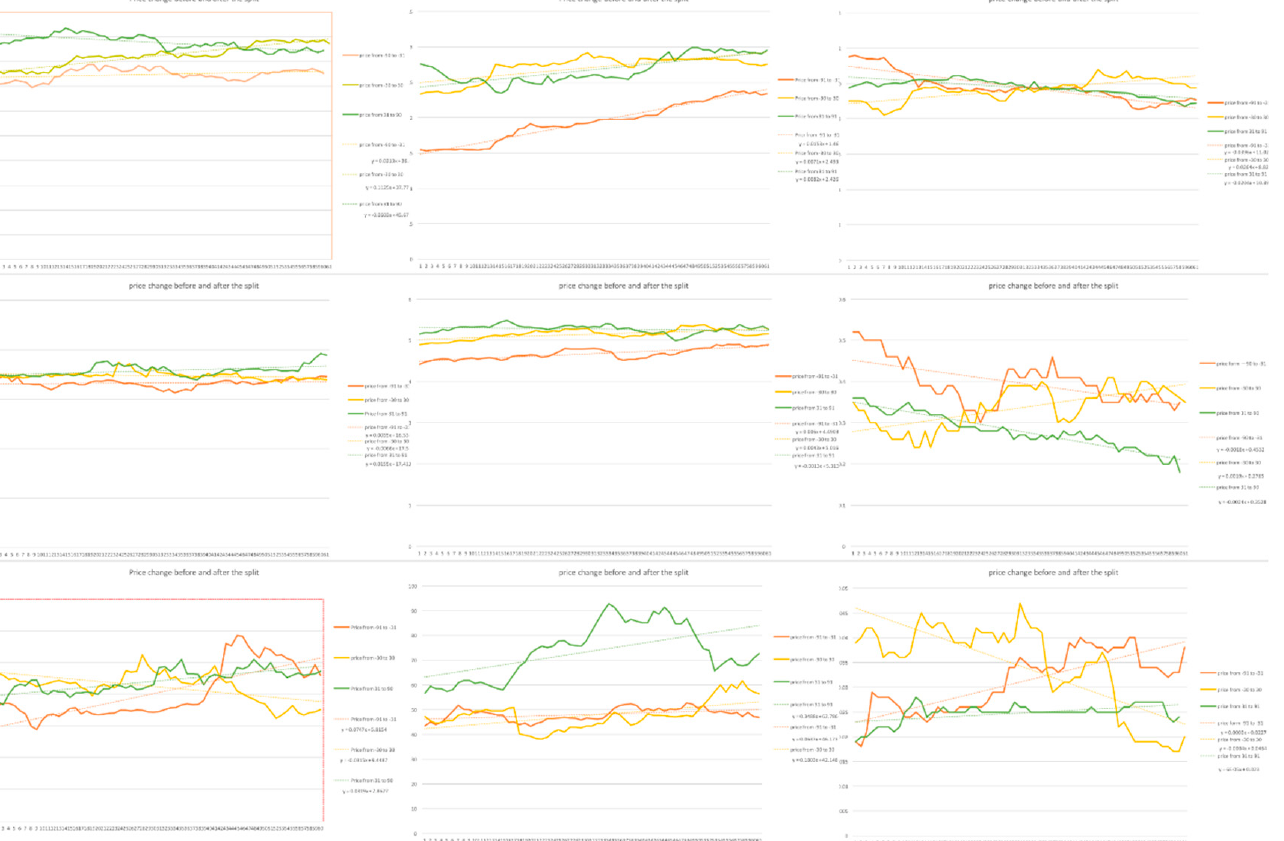
from day − 91 to day − 31; Yellow lines represent stock price from day − 30 to day 30; Green lines